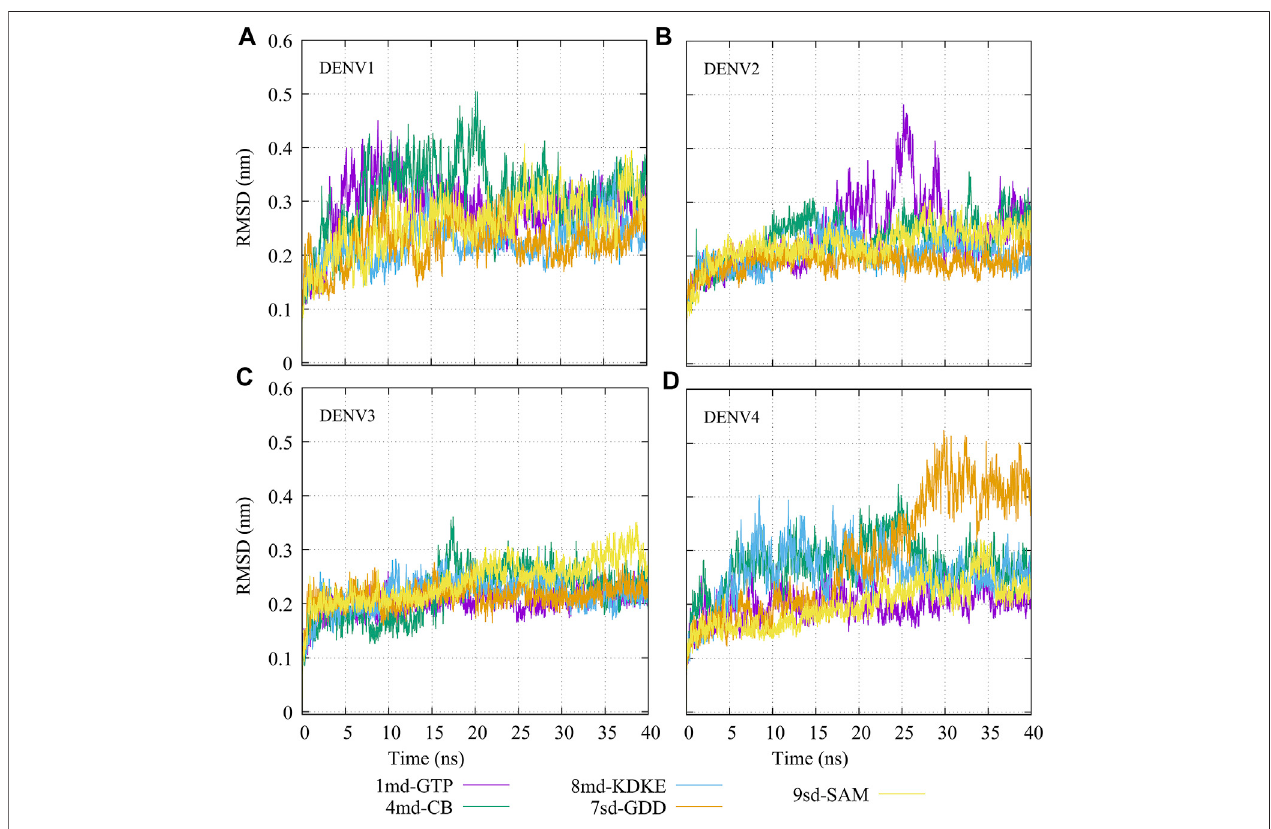
FIGURE 3 | RMSD as a function of the time for the protein – ligand complexes formed by the best compound of each binding site. (A) DENV1, (B) DENV2, (C) DENV3, and (D) DENV4.